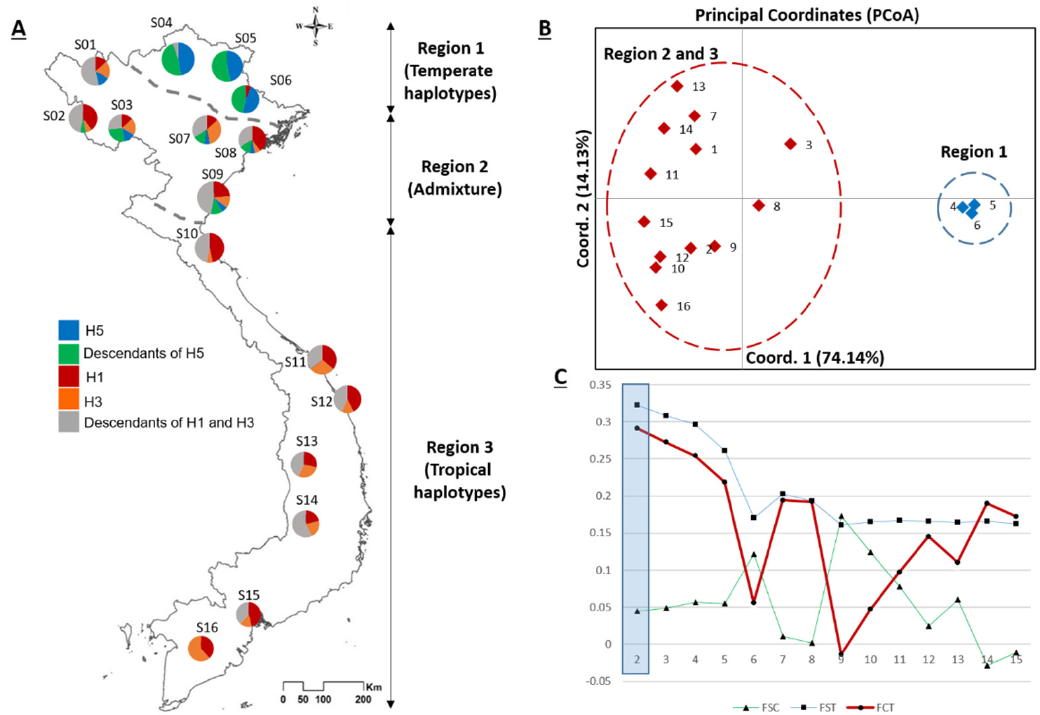
Figure 2. Distribution of COI haplotypes and population structure analyses of 16 Aedes albopictus populations in Vietnam. ( A ) Haplotype distribution map. Each pie chart illustrates the proportion of three major haplotypes and its descendants in each locality. The dashed lines represent the borders of the three regions indicated to the right of the map. ( B ) Principal coordinates analysis (PCoA) plot based on pairwise genetic distance. ( C ) Fixation indices obtained by SAMOVA for the best-clustering option at pre-defined values of K.